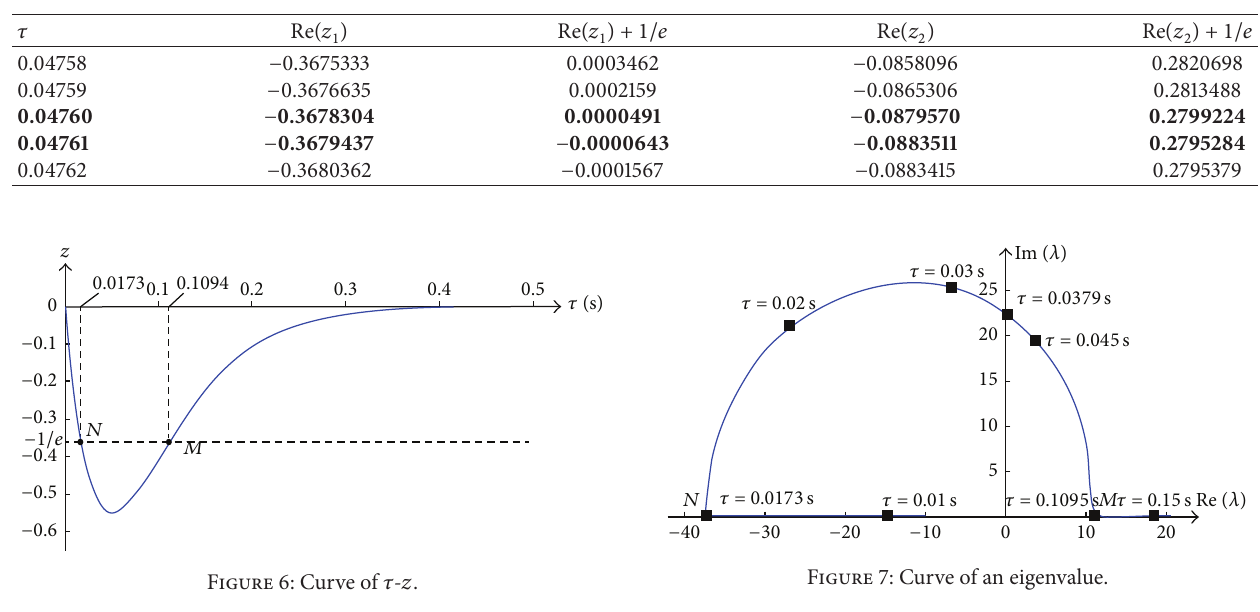
Table 2: 𝑧 1 , 𝑧 2 values near point 𝑄 in Figure 10.